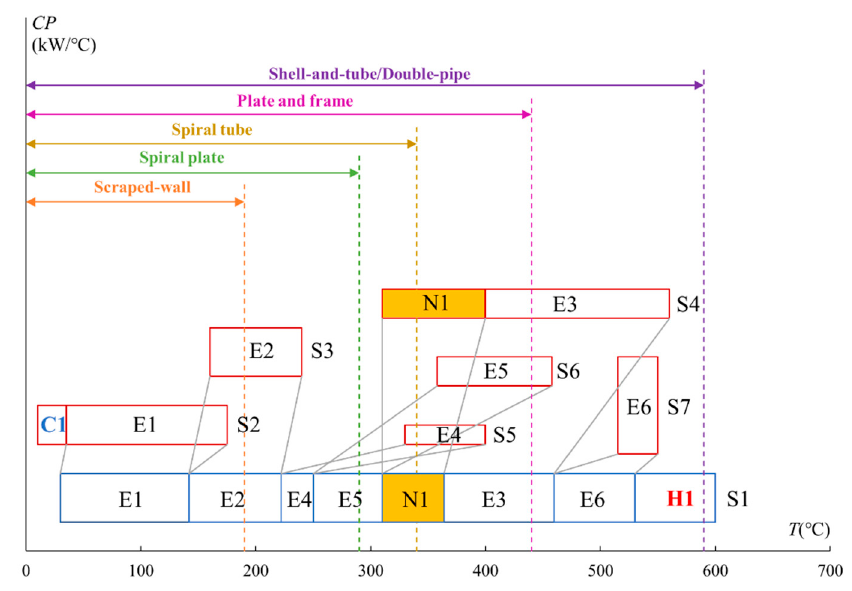
Figure 9. SRTGD-STR if one heat exchanger is added for the case study.